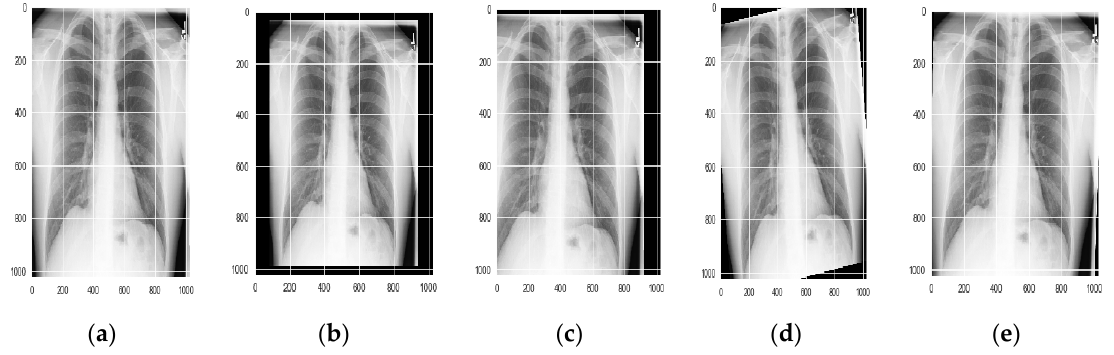
Figure 8. Geometric transformations applied to the image; ( a ) original image ( b ) scaled image ( c ) translated image ( d ) rotated image ( e ) sheared image.